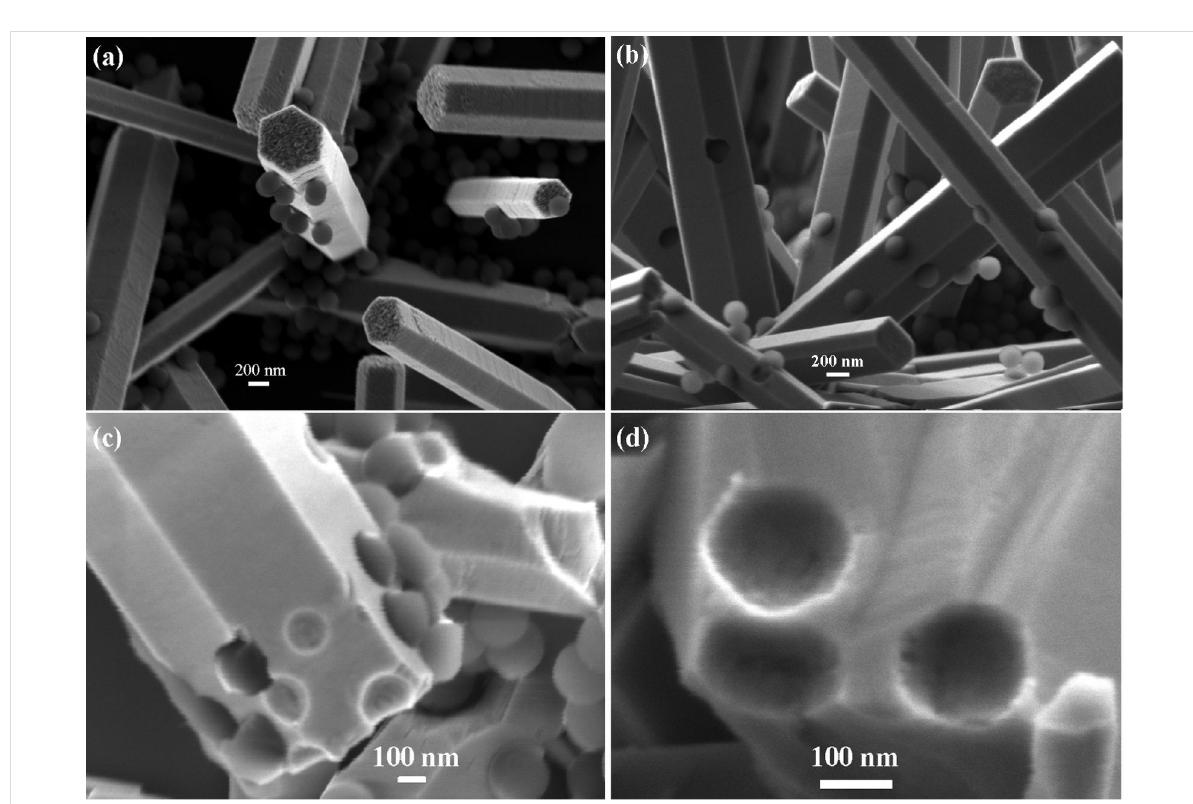
Figure 3: FE-SEM images showing the embedment of 200-nm-diameter polymer nanobeads in ZnO nanorods. (a) ZnO nanorods with polymer nanobeads attached to their surfaces. (b) Nanobeads were embedded in nanorods after a second growth process. These nanobeads were about half- volume exposed. (c) Intentionally fractured nanorods. (d) Close-view of the vacant sites where the nanobeads were broken